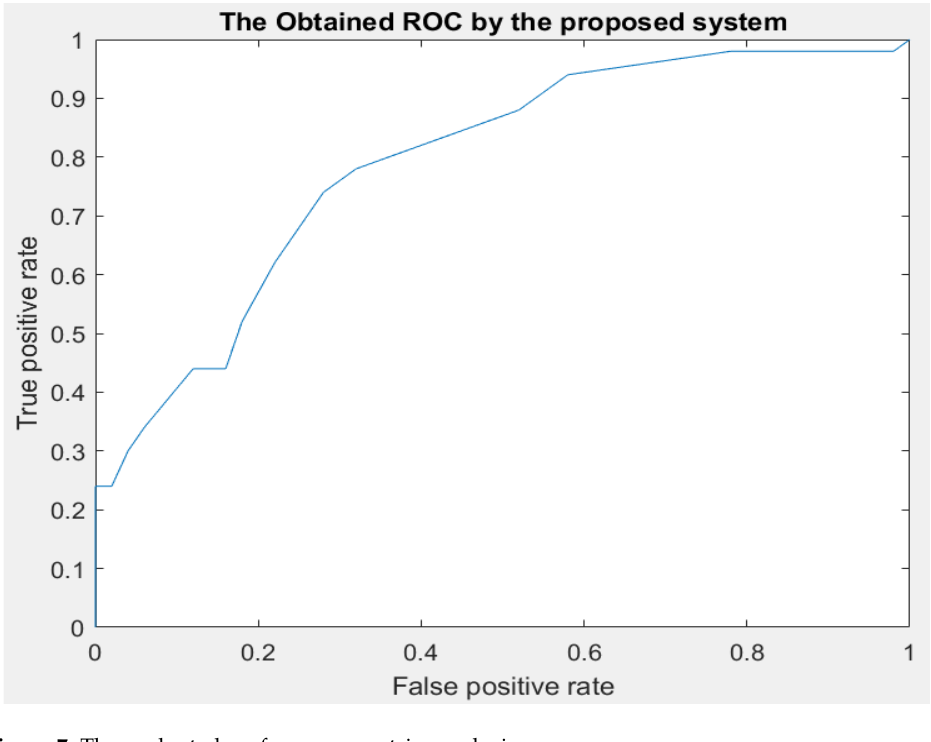
Figure 7. The evaluated performance metrics analysis.